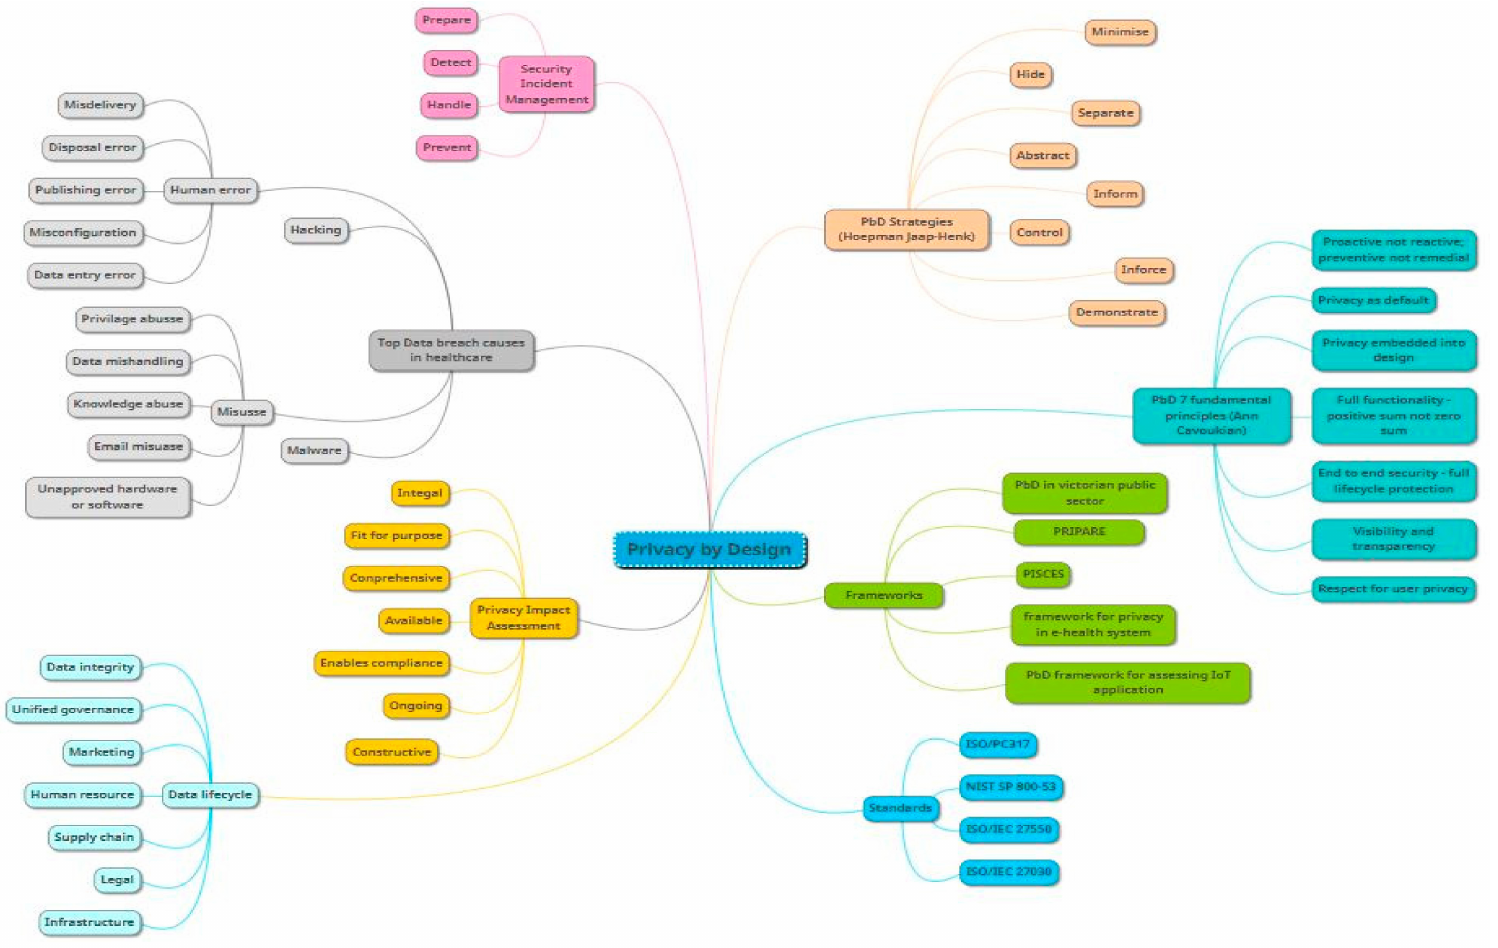
Figure 1. Privacy by design mind map